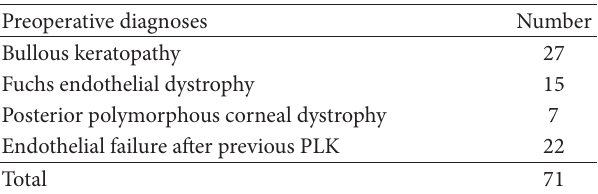
Figure 1: DMEK-S scheme. Table 1: Indications for DMEK-S surgery in our